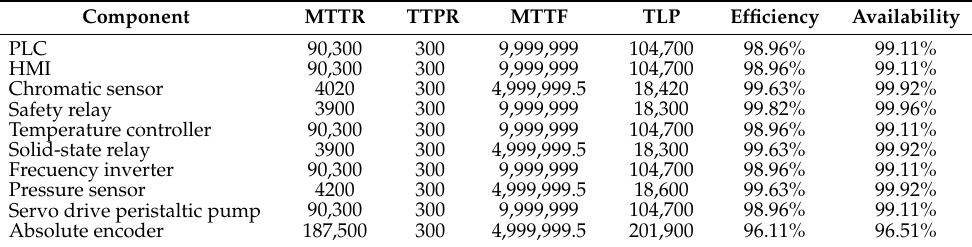
Table 11. Electronic component times in seconds. Efficiency and availability calculated in % with IPPM strategy.